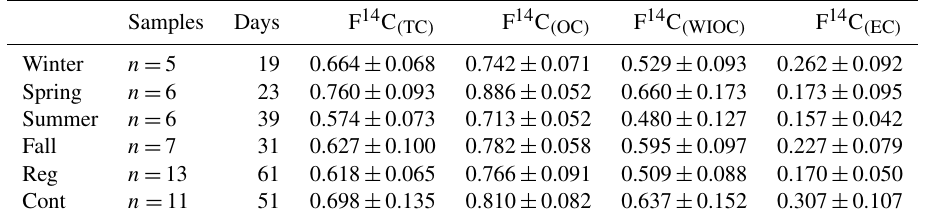
Table 2. Average fraction modern (F 14 C) after blank correction ± standard deviations of F 14 C determination for total carbon (TC), organic carbon (OC), elemental carbon (EC), and water-insoluble organic carbon (WIOC) in different seasons and for regional (reg) and continental (cont) air mass origin. The second column gives the number of samples averaged for each case.